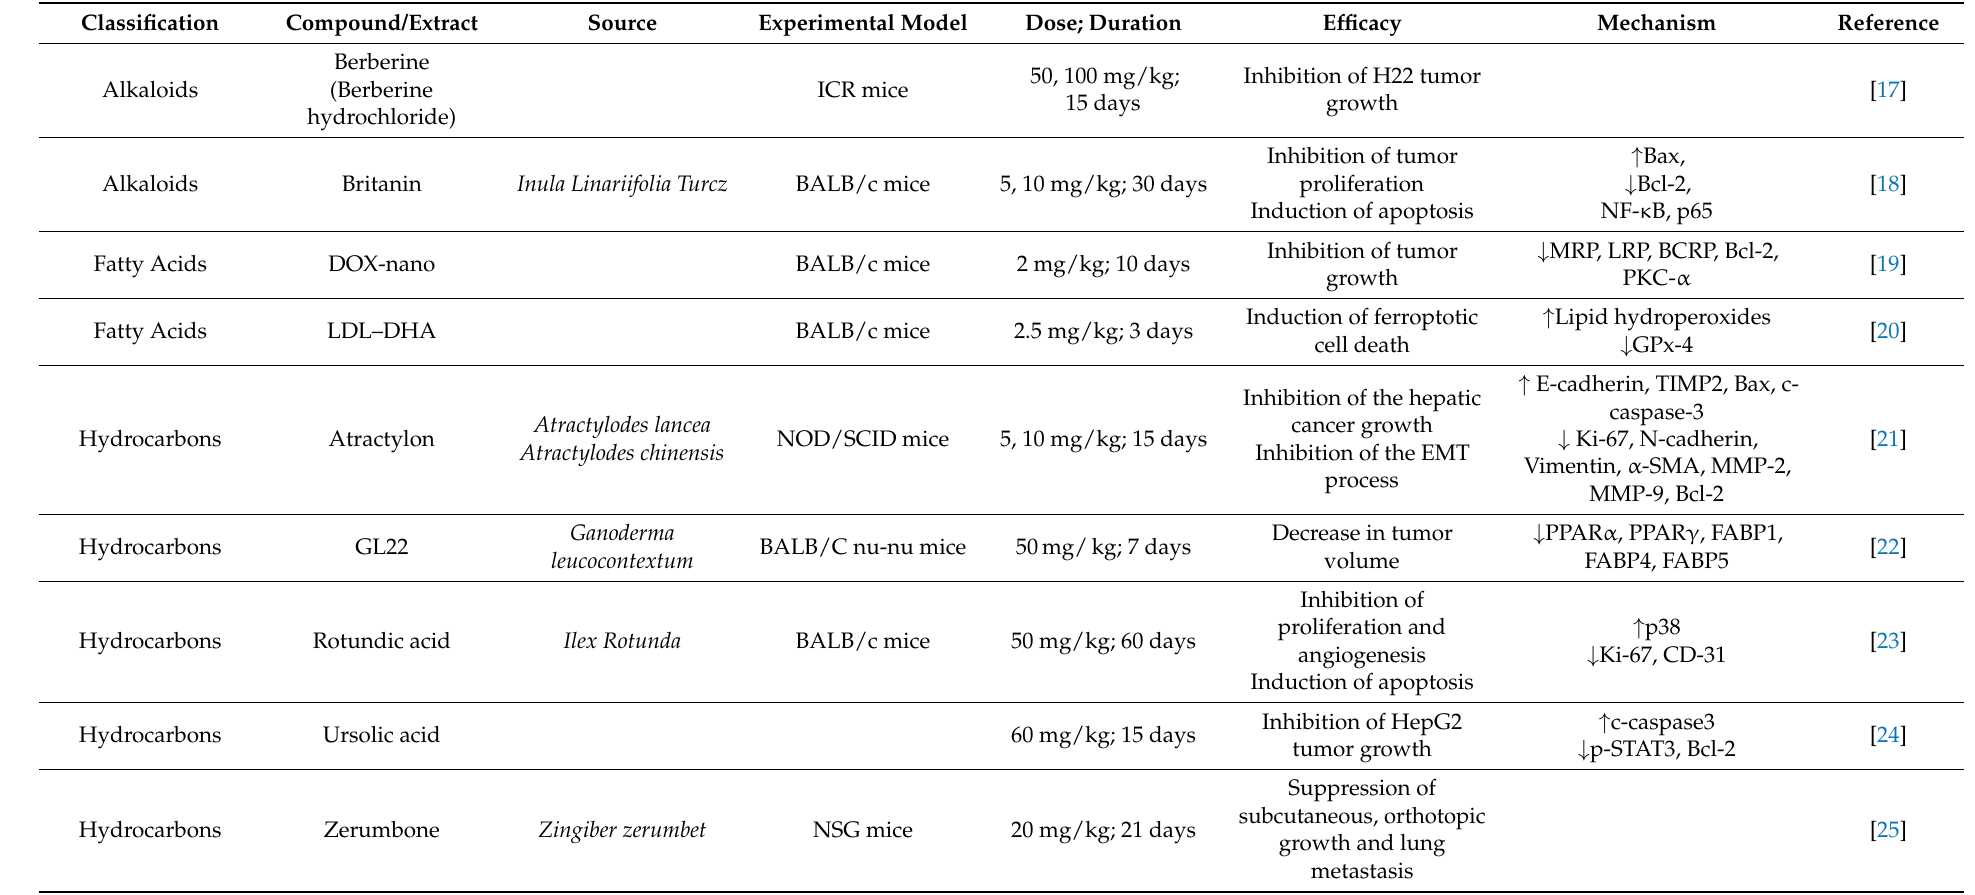
Table 2. In vivo mice-single